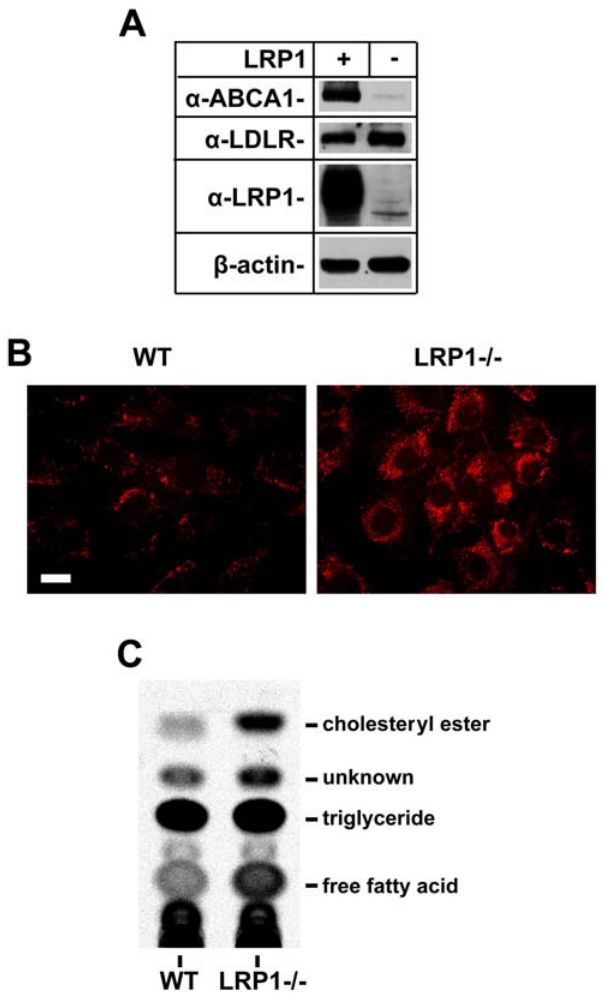
Figure 3. Lipid analysis of primary SMCs. A . Primary SMCs of the indicated genotypes were lysed in freshly prepared lysis buffer. 10 m g of protein extracts were loaded on 4–15% SDS-PAGE gels. Blots were then probed with the rat anti-mouse ABCA1 monoclonal antibody, a rabbit anti-LDLR polyclonal antibody, and a rabbit anti-LRP1 polyclonal antibody. b -actin was detected to demonstrate equal loading. Western blotting consistently confirmed significantly reduced ( , 5 fold) ABCA1 and increased LDLR protein expression (1.67 6 0.12, n=3 and [36]) in primary SMCs lacking LRP1. B . Cells grown on coverslips were fixed with 10% formalin and stained with 4 mg/ml Oil Red O in isopropyl alcohol. Oil red O staining showed increased lipid accumulation in LRP1- deficient cells (right panel). Images were captured on a Zeiss